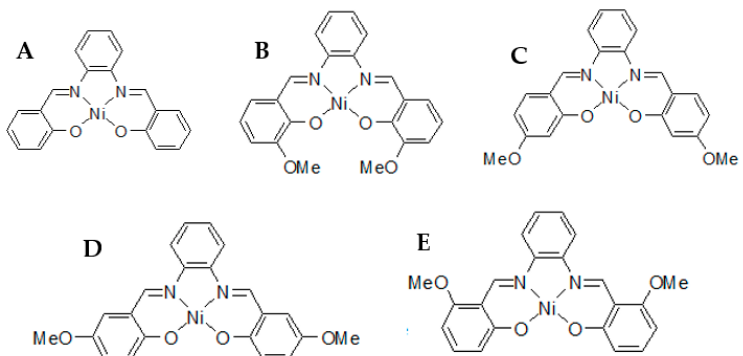
Figure 1. Chemical structures of ( A ) Ni II (salophene), ( B ) Ni II (3-OMe-salophene), ( C ) Ni II (4-OMe- salophene), ( D ) Ni II (5-OMe-salophene), and ( E ) Ni II